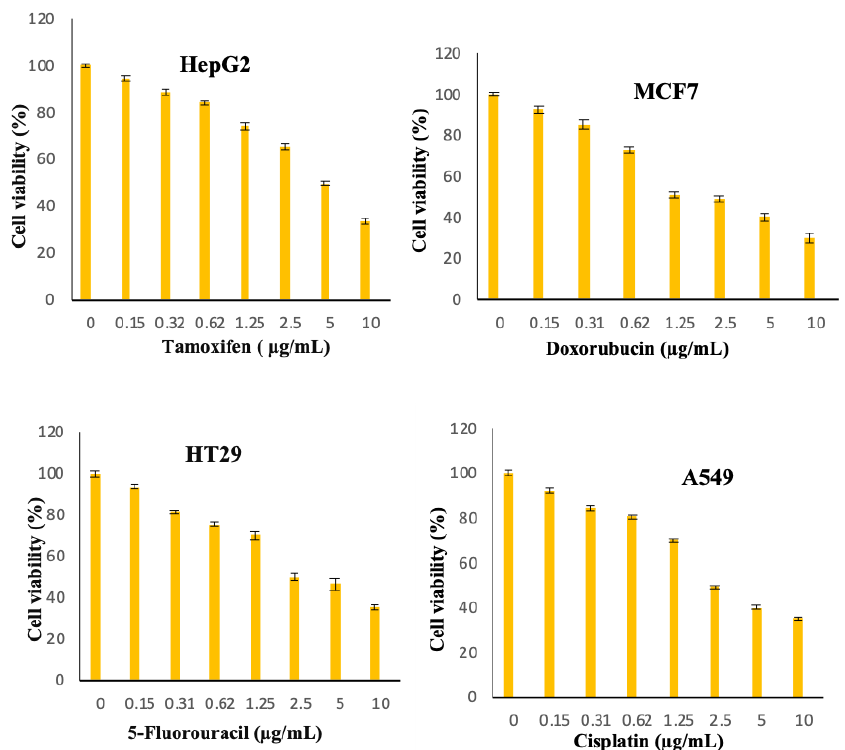
Figure 12. Chemotherapeutic effects on the viability of treated cells (MCF7, HepG2, A549, and HT29) using MTT assay after 48h.